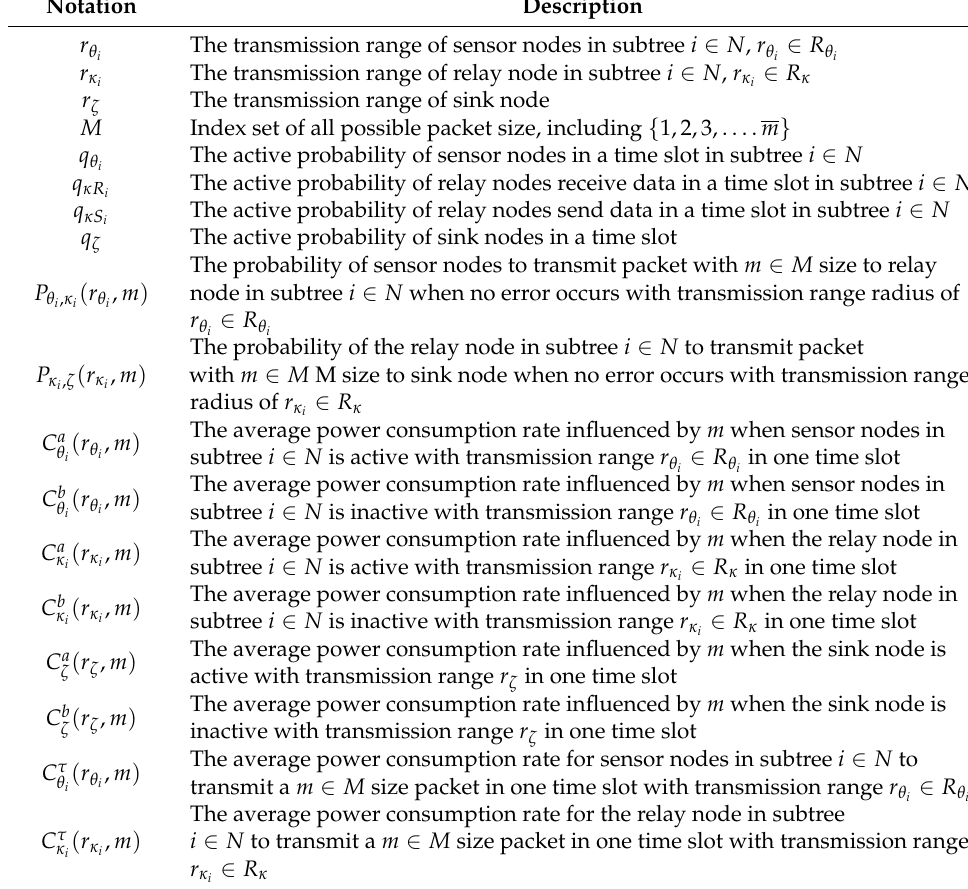
Table 2. Decision Variables.